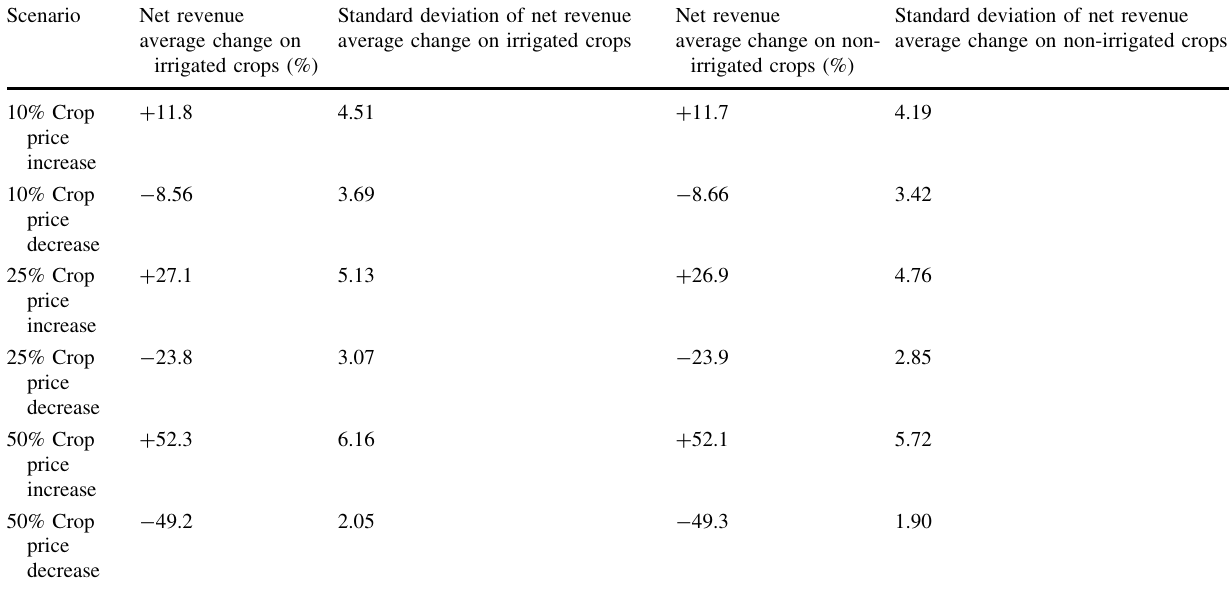
Table 4 Sensitivity analysis illustrating average net revenue change (%) when crop prices on non-irrigated and irrigated crops were adjusted